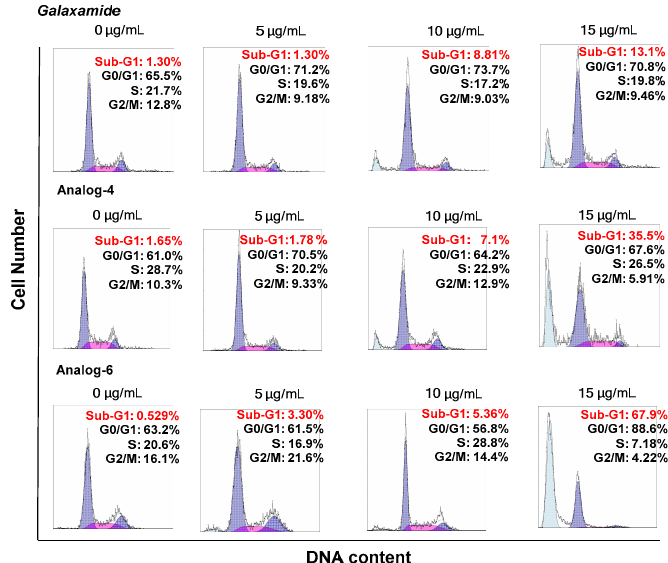
Figure 3. Cell cycle of HepG 2 cells after 48 h of treatment with Galaxamide, Analog-4 and -6 with concentrations of 0, 5, 10 and 15 µg/mL. Sub-G1 (light blue peak), G0/G1 (light purple peak), S (pink peak) and G2/M (dark purple)